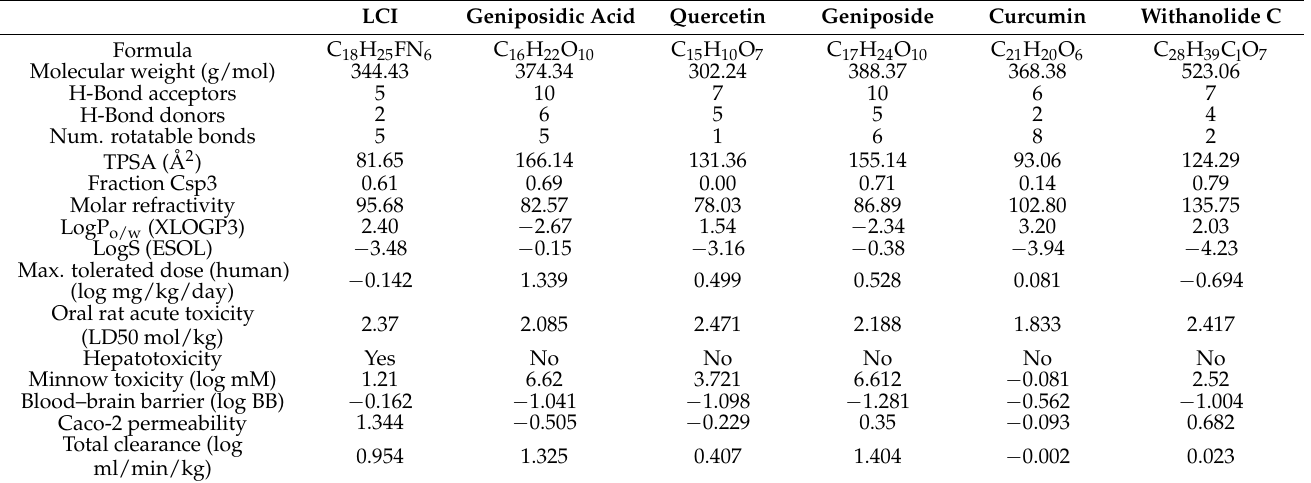
Table 2. ADMET properties (obtained from the SwissADME and the pkCSM databases) of LCI, geniposidic acid, quercetin, geniposide, curcumin, and withanolide C. LCI Geniposidic Acid Quercetin Geniposide Curcumin Withanolide C